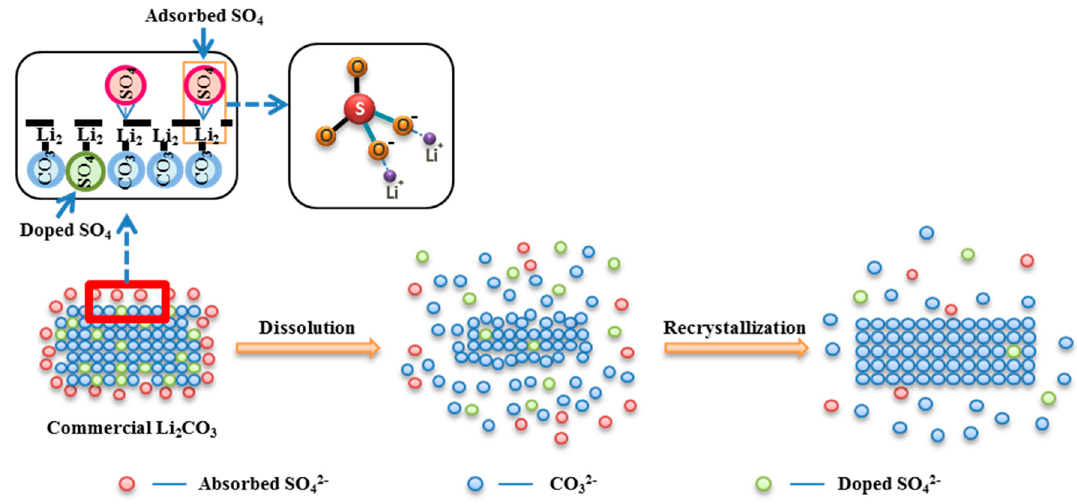
Figure 6. XRD spectra of ( 110 ), ( 202 ) and (002) planes of Li 2 CO 3 samples after recrystallization in Na 2 CO 3 solution.